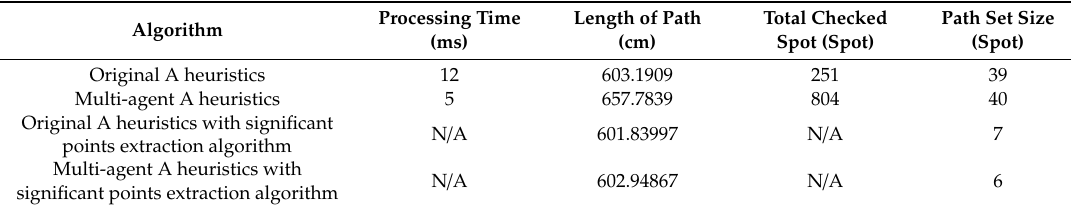
Table 3. Indices obtained by original A-heuristic algorithm and multi-agent A-heuristic algorithm with or without the presence of a reduction path algorithm in the first scenario.